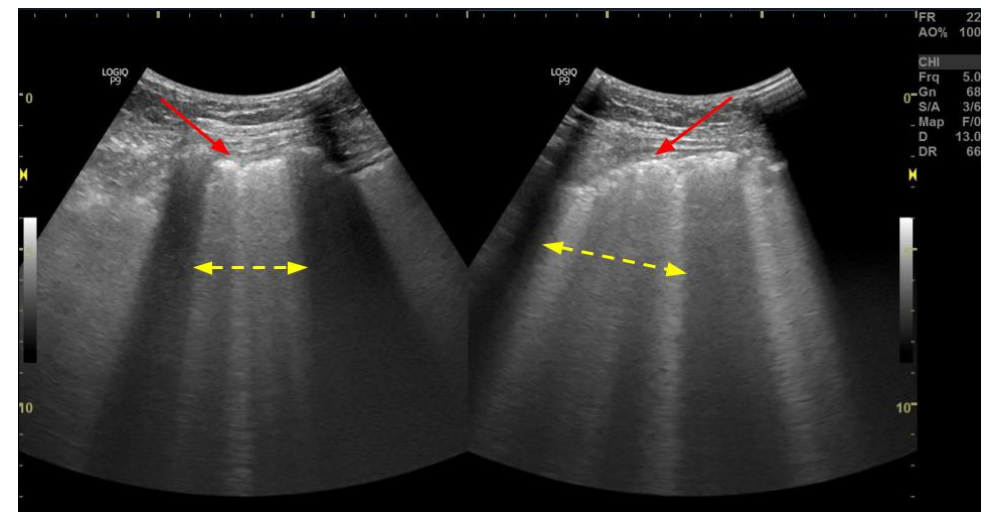
Figure 6. Ultrasonographic interstitial syndrome—more than 2 B-lines per intercostal space (yellow arrows) (“lung rockets”). Additionally, thickening and blurring of the pleural line and small subpleural consolidations are seen (red arrows). Figure were acquired in the Department of Internal Medicine, Pulmonary Diseases and Allergy, Medical University of Warsaw.